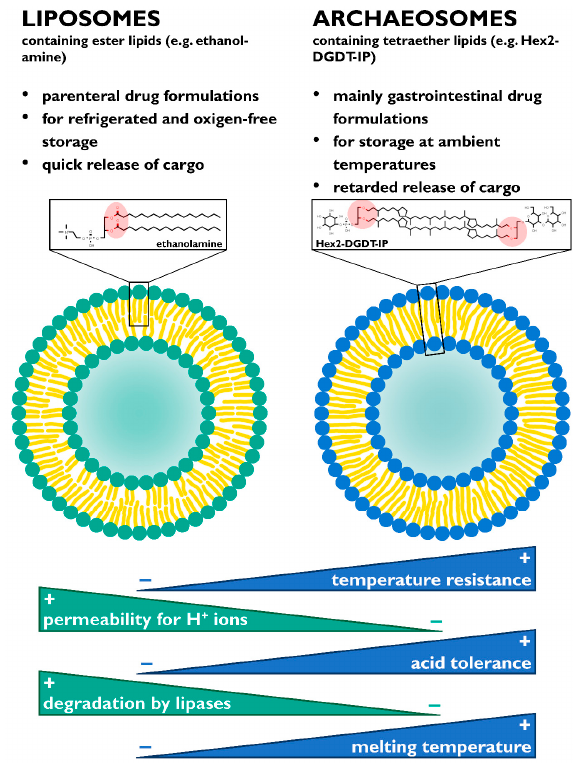
Figure 4. Summary of properties and applications of archaeosomes and comparison between archaeosomes and conventional liposomes.